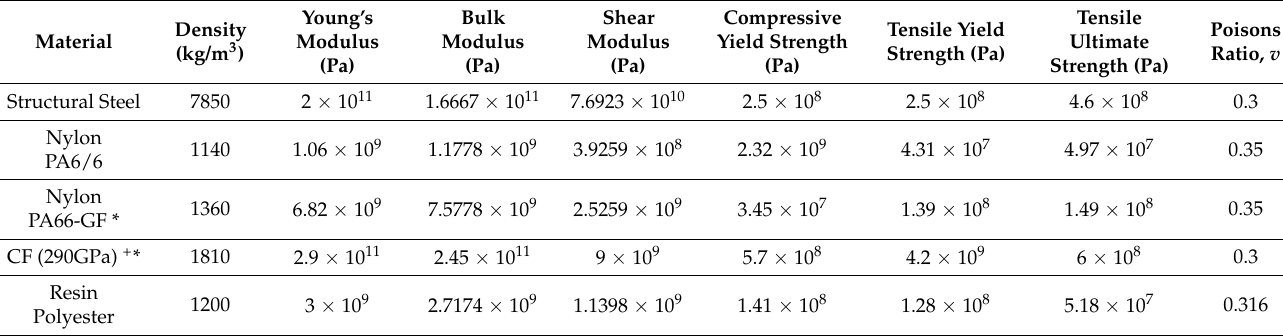
Table 1. Material properties for steel and composites.